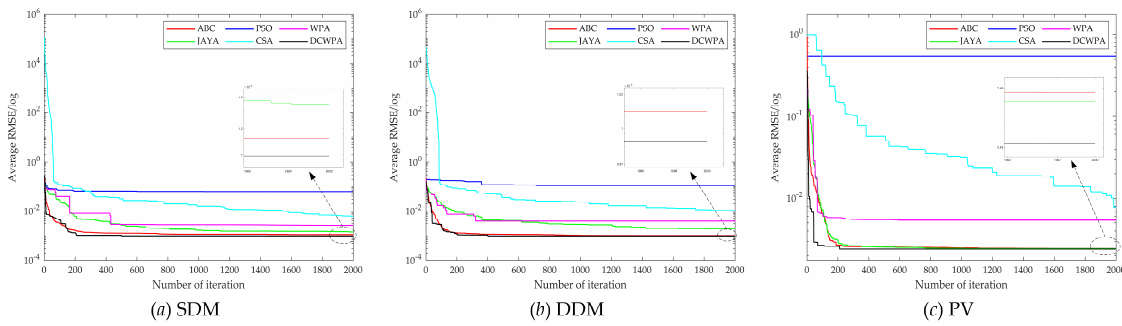
Figure 14. Convergence curves of the algorithm solution.